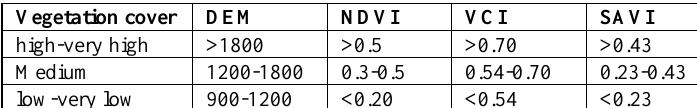
Table 2: Summary of the values of vegetation indexes for high to very high, medium, and low to very low vegetation cover and its distribution with